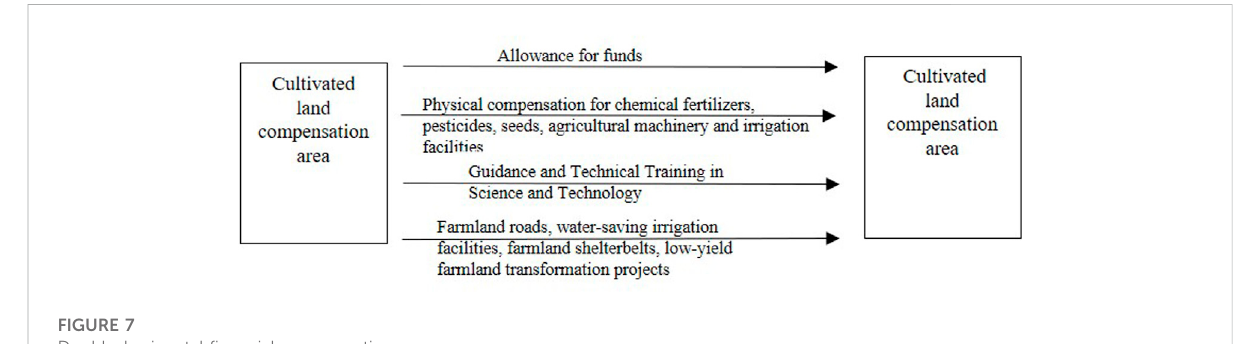
FIGURE 7 Double-horizontal fi nancial